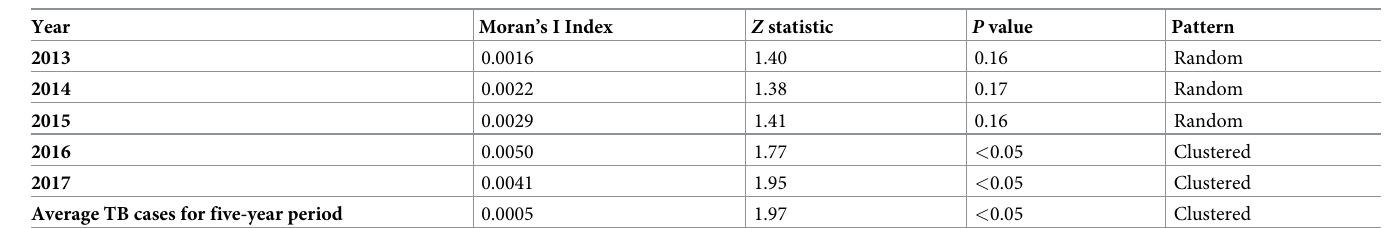
Table 1. Global Morans’ I index for the TB cases in Gombak, 2013 to 2017.